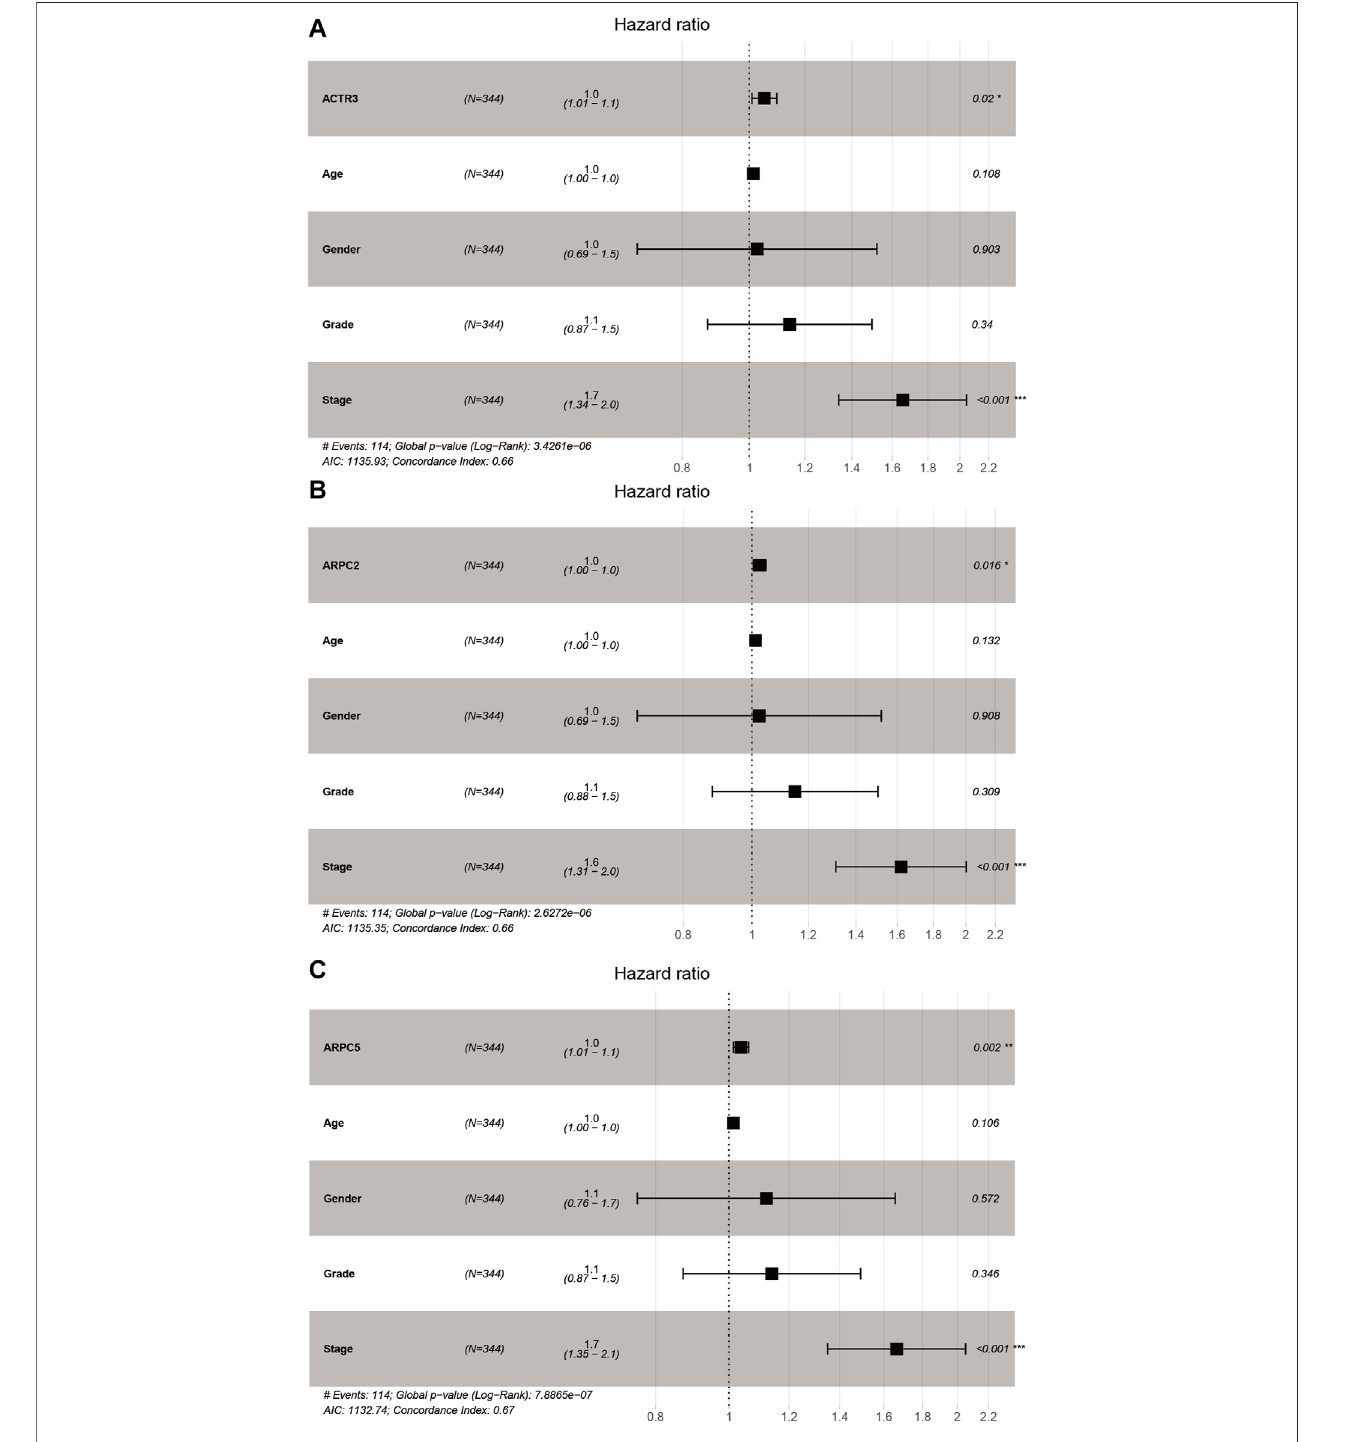
FIGURE 9 | Forest plots of multivariate Cox regression analysis of Arp2/3 members with signi fi cant prognostic signi fi cance. (A) ACTR3; (B) ARPC2; and (C) ARPC5. * p < 0.05; ** p < 0.01; *** p < 0.001.